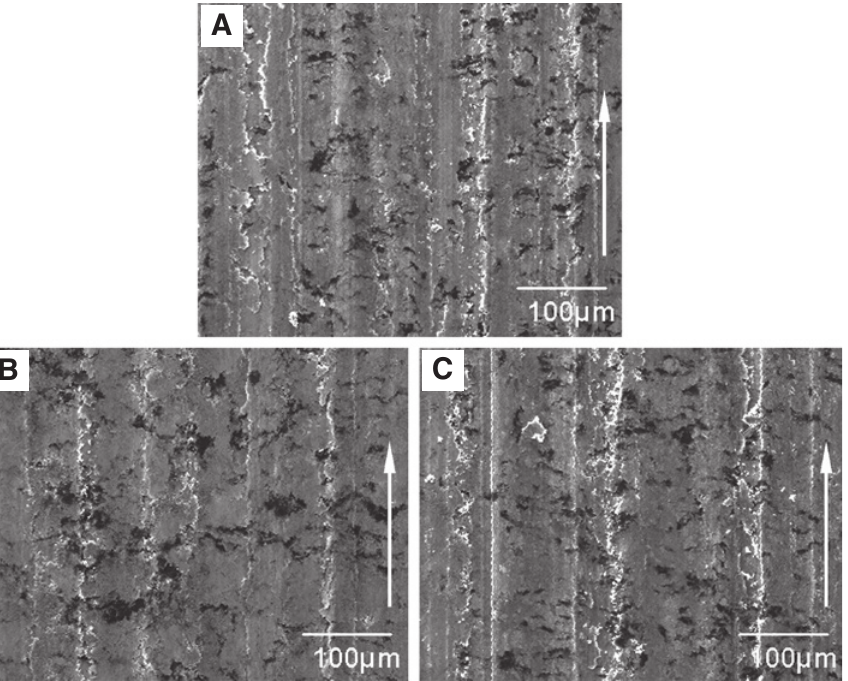
-graphite-multi-wall WS nanotubes (Cu-WS - 2 2 2